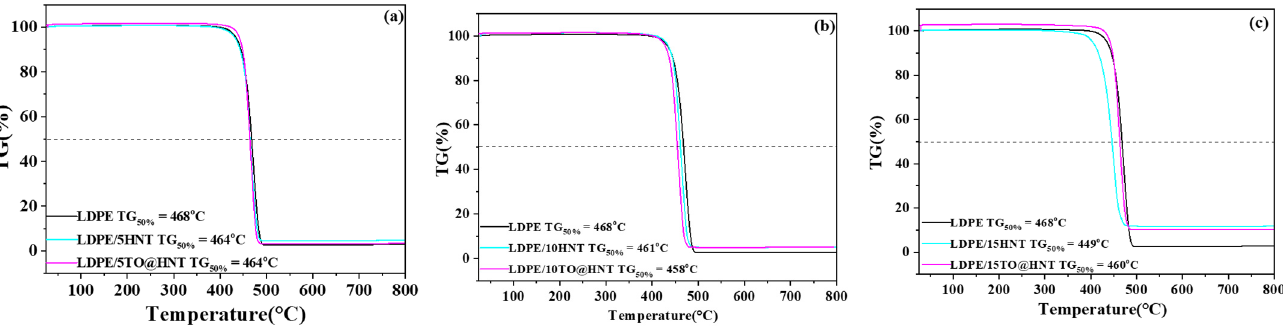
Figure 8. TG plots of ( a ) LDPE/5HNT, LDPE/5TO@HNT films, ( b ) LDPE/10HNT, LDPE/10TO@HNT films, and ( c ) LDPE/15HNT, LDPE/15TO@HNT films. In each graph, the TG plot of pure LDPE film is also presented for comparison.